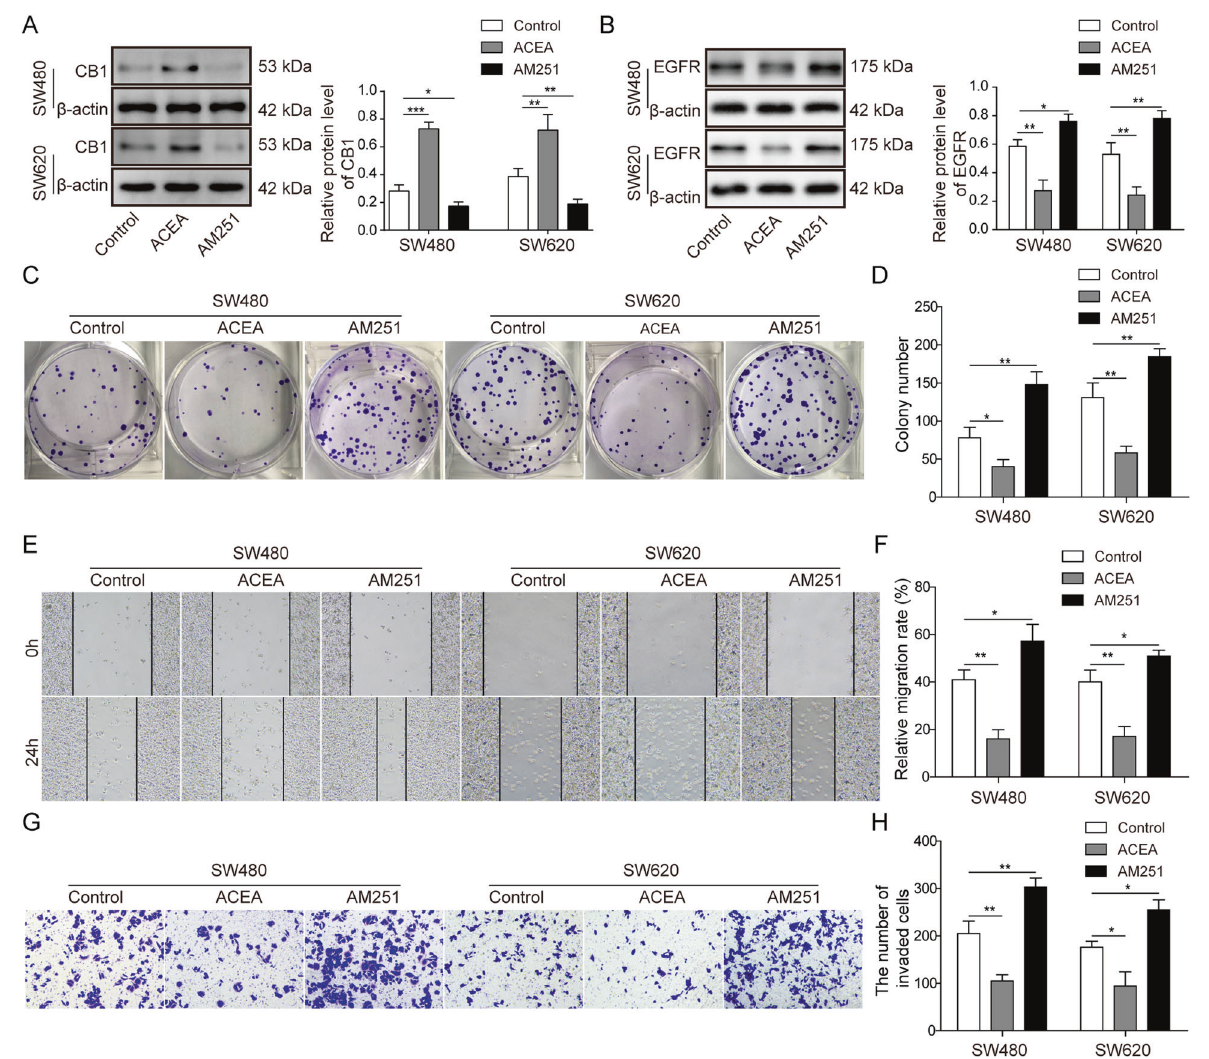
Fig. 2 CB1 activation suppressed the proliferation, migration and invasion of colorectal cancer cells. A Western blot assay tested the protein level of CB1 after ACEA and AM251 treatment. B Western blot analysis showed that CB1 activation signi fi cantly decreased the expression of EGFR while its inhibition increased the expression of EGFR. C, D Colony forming assay showed that CB1 activation suppressed colony formation of colorectal cancer cells, while its inhibition promoted colony formation. E, F Wound healing test showed that CB1 activation prevented cell migration while CB1 inhibition enhanced cell migration of colorectal cancer cells. G, H Transwell invasion assay demonstrated that CB1 activation blocked cell invasion while CB1 inhibition enhanced cell invasion of colorectal cancer cells. * P < 0.05; ** P < 0.01; *** P <